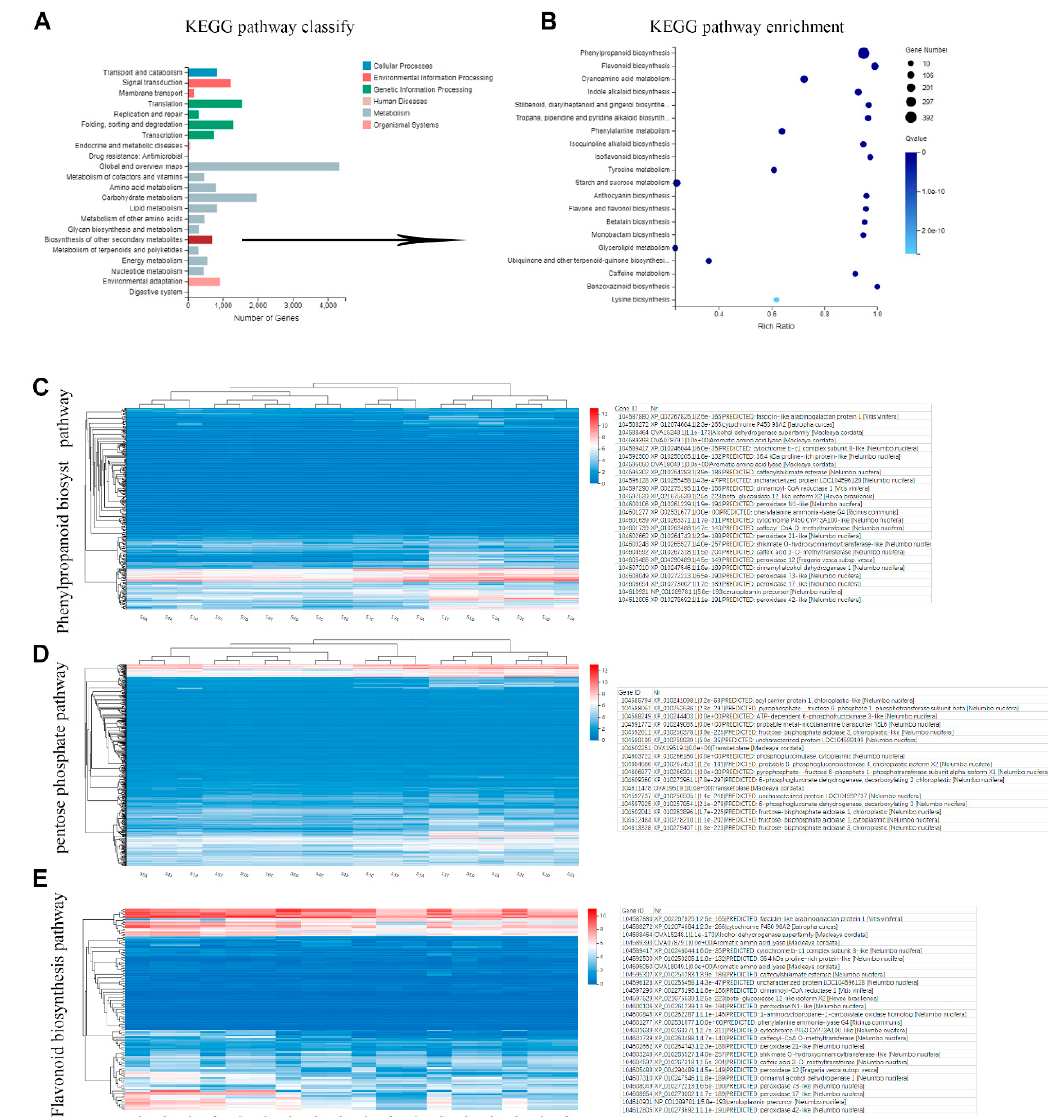
Figure 4. Overview of genes involved in biosynthesis pathway of phenols in six rhizome transcriptomes. ( A ) Gene ontology (GO) annotation of total genes in these transcriptomes. ( B ) Kyoto Encyclopedia of Genes and Genomes (KEGG) pathway enrichment of genes involved in secondary metabolism. Pathways were enriched with Q values. ( C ) Heatmap of expressed genes assigned to the phenylpropanoid biosynthesis pathway; highly expressed genes were selected and are listed on the right. ( D ) Heatmap of genes involved in the pentose phosphate pathway; highly expressed genes were selected and are listed on the right. ( E ) Heatmap of genes involved in the flavonoid biosynthesis pathway; highly expressed genes were selected and are listed on the right.